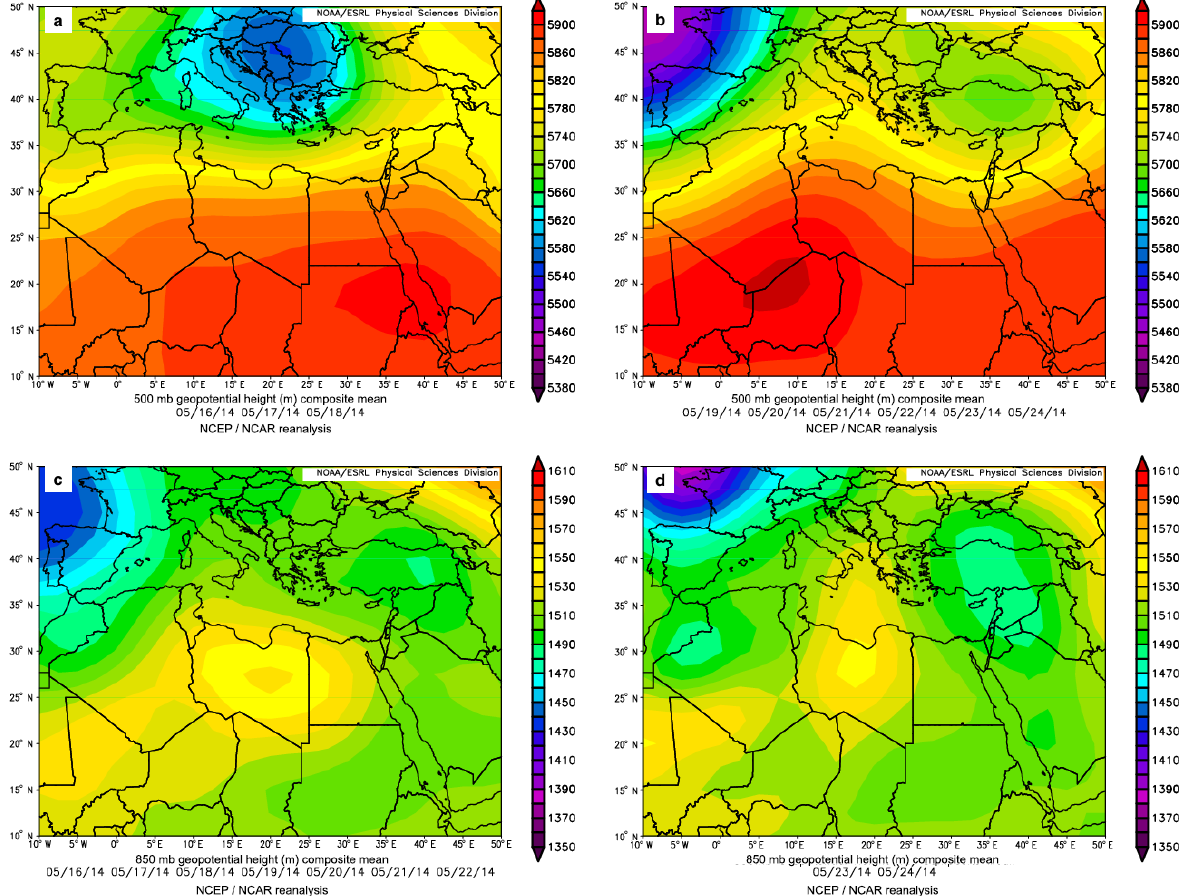
Figure 2. Time averaged maps of geopotential height obtained using the NCEP/NCAR Reanalysis over the periods (a) 16 to 18 May 2014 at 500hPa, (b) 19 to 24 May 2014 at 500hPa, (c) 16 to 22 May 2014 at 850hPa, and (d) 23 to 24 May 2014 at